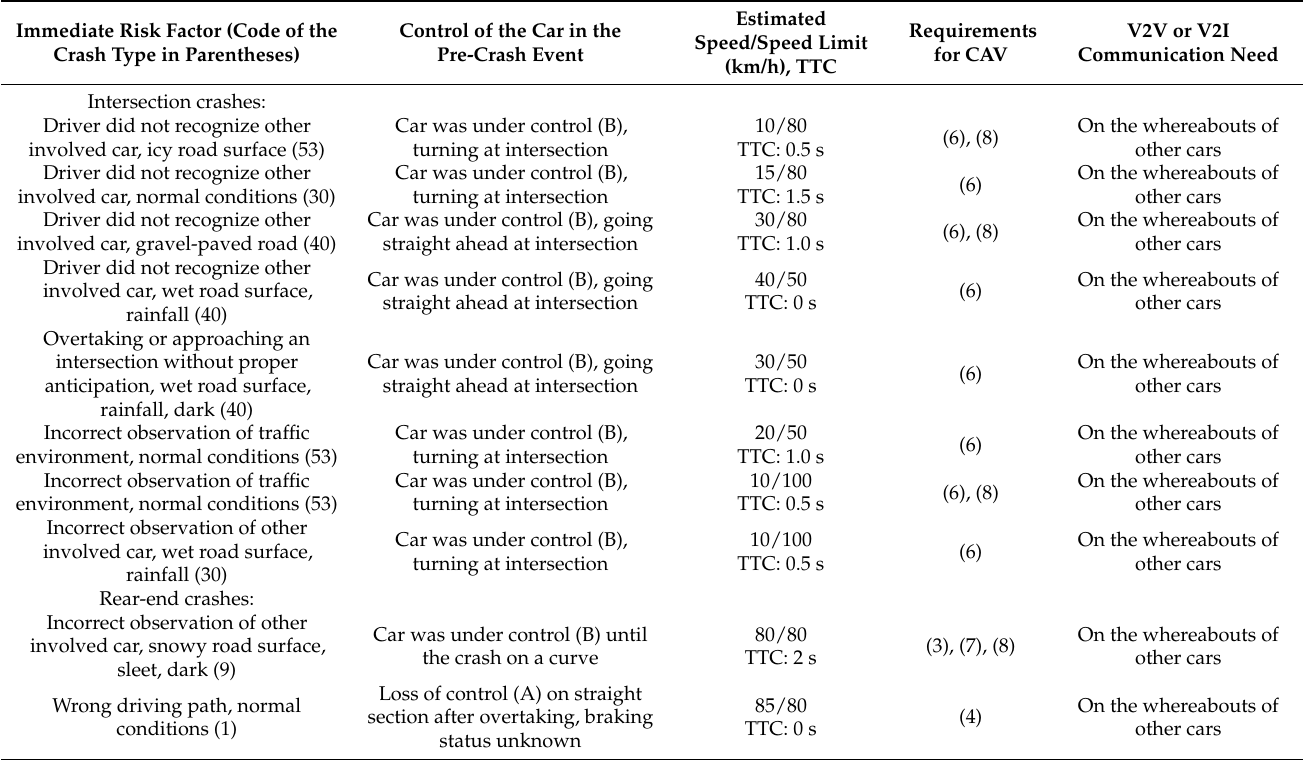
Table 3. Characteristics of the eight studied intersection crashes and the two rear-end crashes from the at-fault driver’s point of